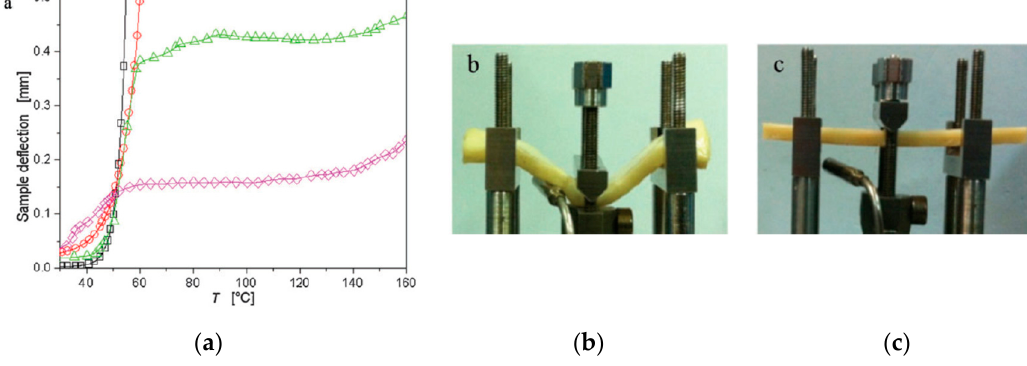
Figure 4. ( a ) Sample deflection recorded during creep tests for the sample PLA (squares), polyamide 11 (PA11) (diamond), PLA70 (circles), and PLA70-silicate at 3 wt.% (triangles). ( b , c ) The pictures show the samples PLA70 and PLA70-silicate at the end of the test, that is, after the temperature had reached ≈ 160 ◦ C [38], Reproduced with permission from Nuzzo A, Macromol. Mater. Eng.; published by Wiley, 2014 .